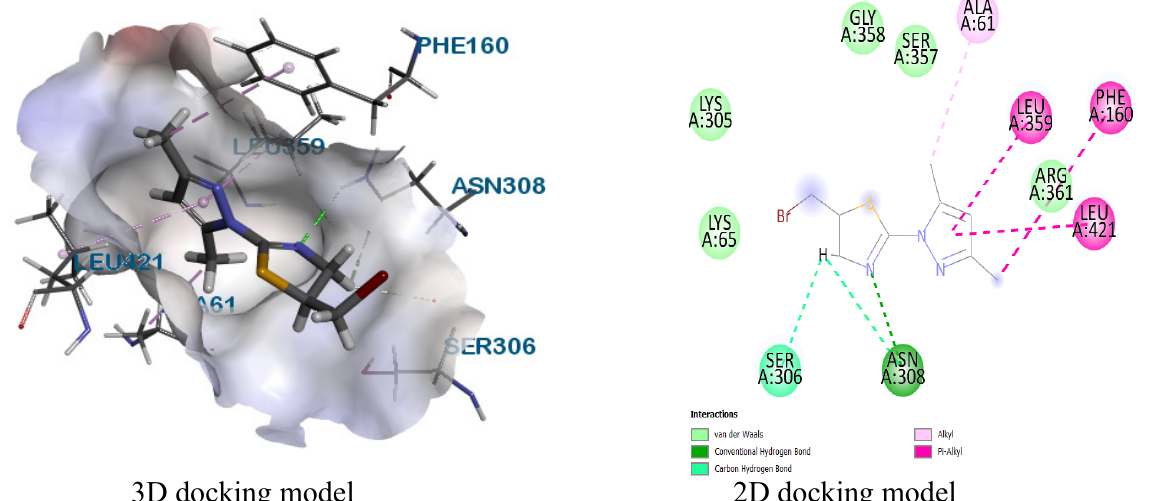
Figure 4. Complex between 8 and Penicillin binding protein 4 E.coli “Homo sapiens” (2EXB).